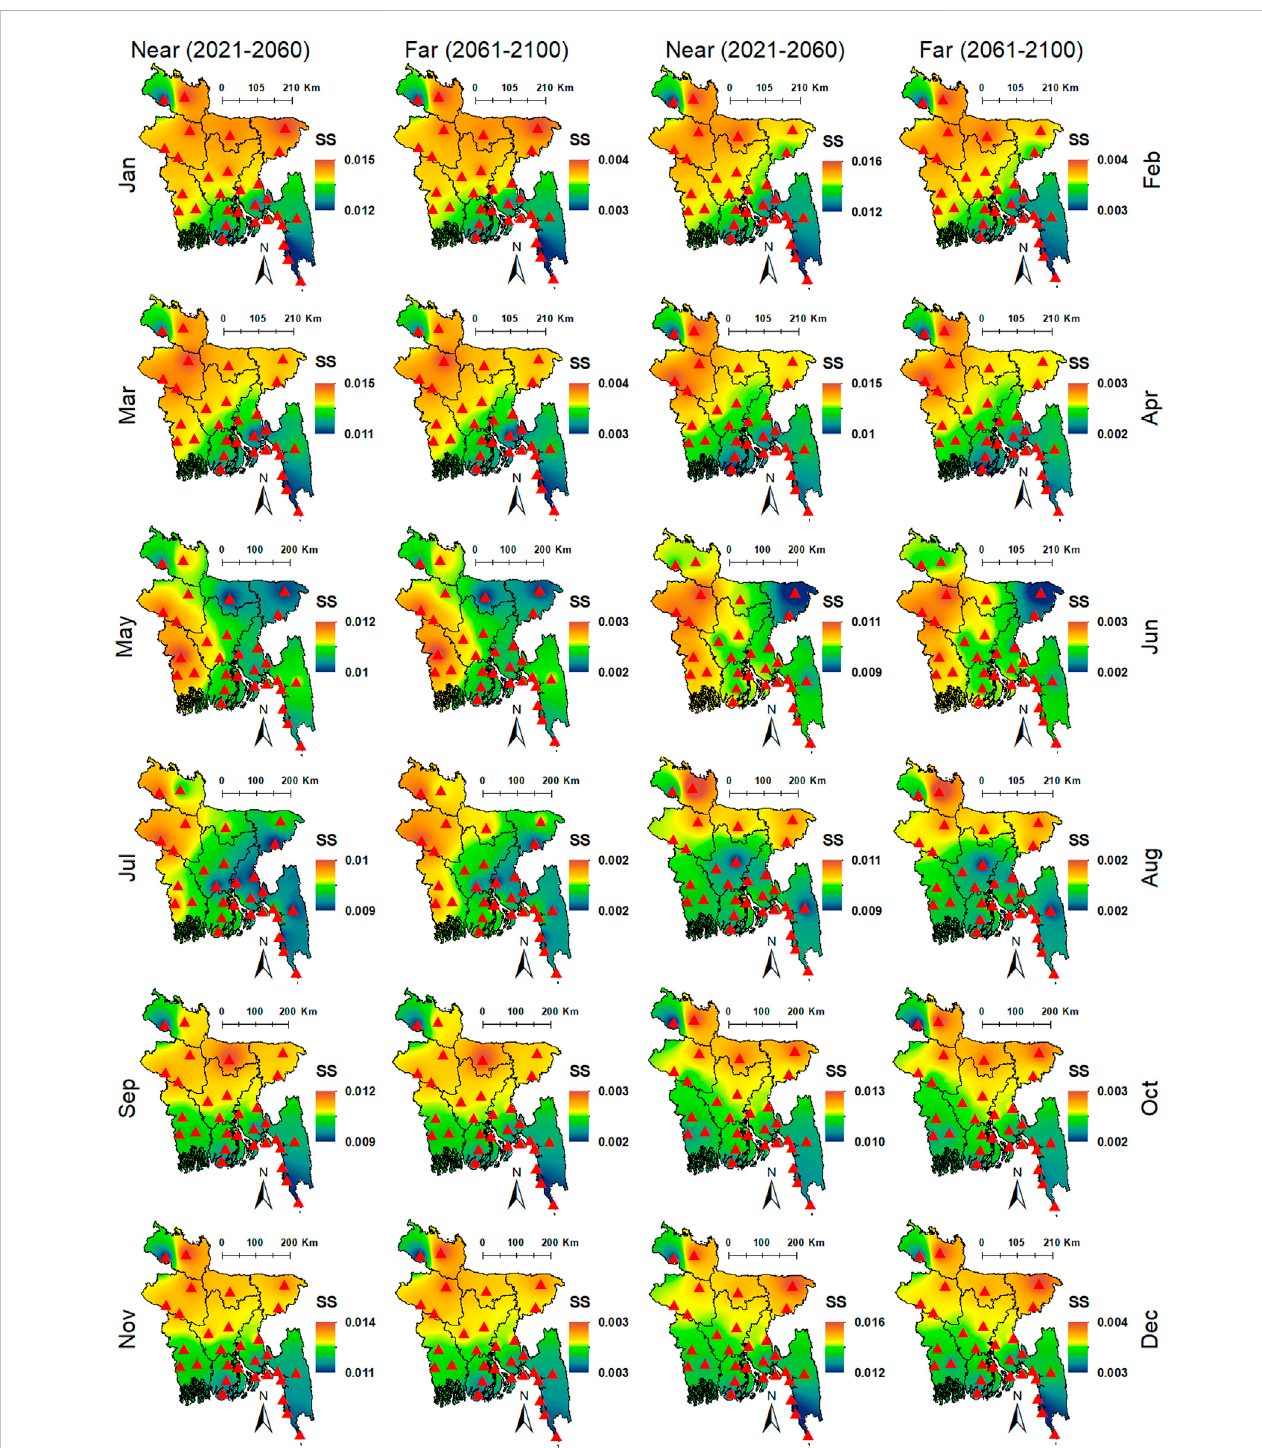
FIGURE 3 Spatial distribution of monthly (Jan-Dec) Tmax ( o C ) trends (SS) for near (2021 – 2060) and far (2061 – 2100) futures periods over Bangladesh considering 30 meteorological stations for RCP4.5.